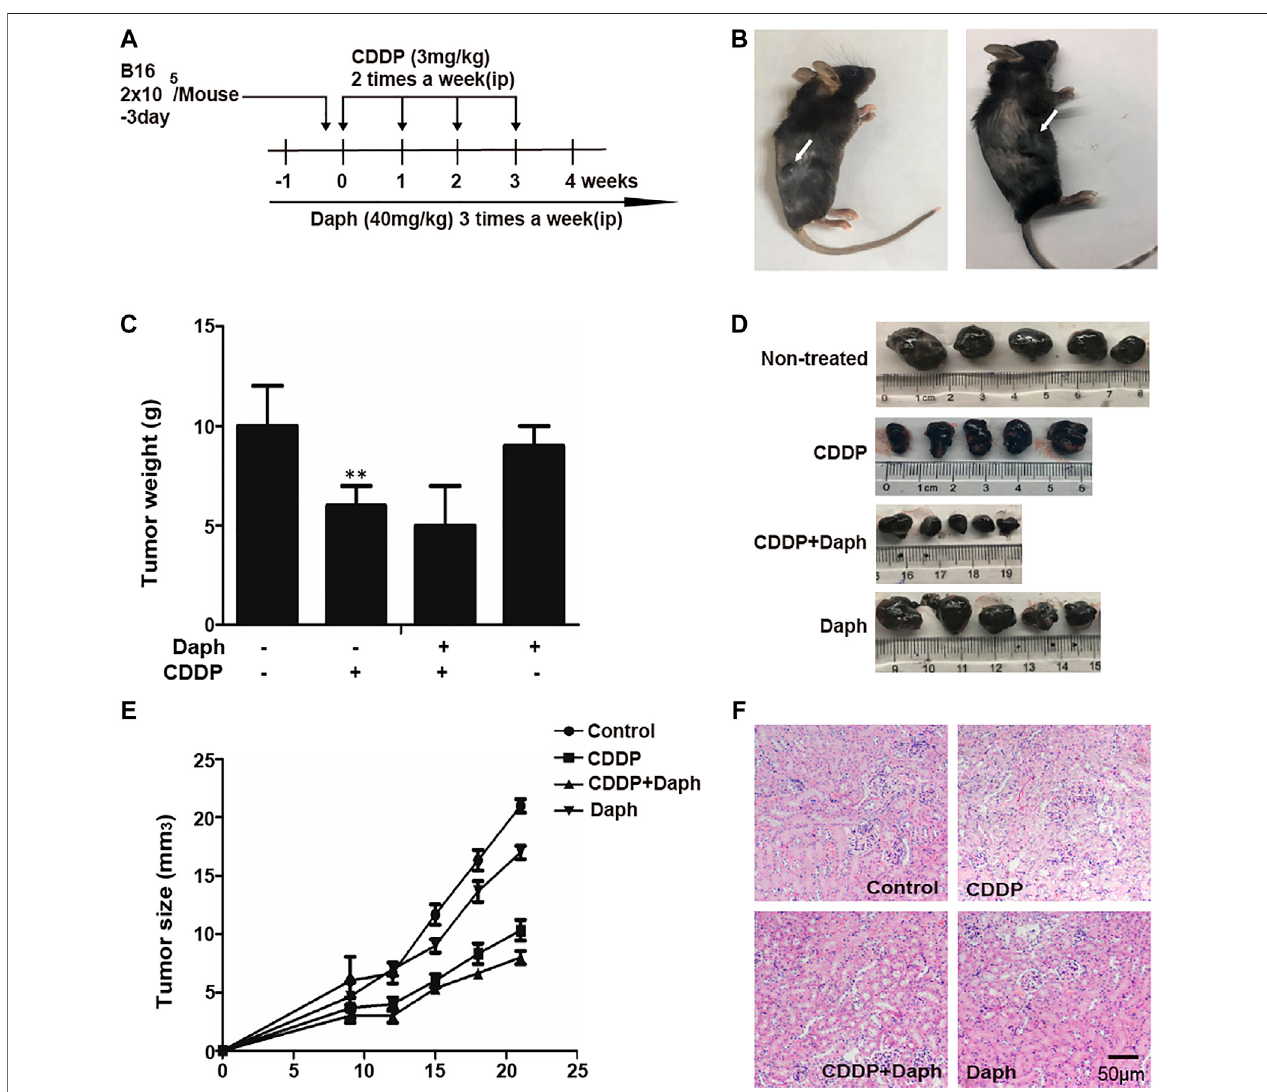
FIGURE 12 | Daph did not compromise the tumoricidal activity of CDDP in mice. (A) Experimental study design and time chart for assessing the effect of Daph on the tumoricidal activity of CDDP in mice. B16 melanoma cells (2 × 10 5 /mouse) were inoculated into subcutaneous femoral left region of mice 3 days before an initial injectionofCDDP.CDDPwasintraperitoneallyinjectedtwotimesperweekat3 mg/kgbodyweight,andDaphwasadministeredthreetimesperweekat40 mg/kgbody weight from 1 to 4 weeks. Four weeks after the initial injection of CDDP, all mice in each group were assessed to evaluate various parameters. (B – E) The tumor volume was measured. Melanoma solid tumor was removed at 4 weeks, photographed, weighed and measured (F) Kidney specimens were stained with H&E. Data show the Mean ± SEM, and are representative of three independent experiments. ** p < 0.01 vs. the control group.